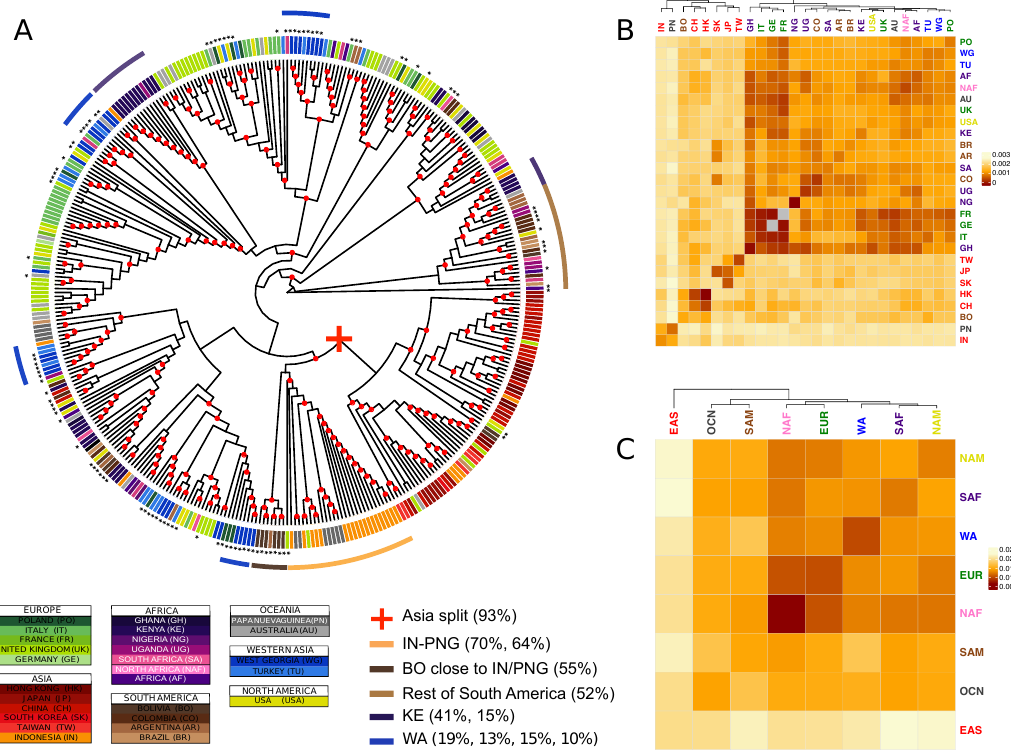
Figure 1. Major phylogenetic relationships. ( A ) Supertree generated by combining the phylogenies of all genes. The strain labels are coloured by country of origin. The countries of the same continent are coloured by di ff erent shades of the same colour. The new sequences produced in this study are identified by black asterisks. Nodes with bootstraps values higher than 0.5 are indicated with a red circle. ( B , C ) Heatmap representing the bootstrapped pairwise genetic distances between EBV populations weighted per all genes in the data set. Populations IDs correspond to the country of origin ( B ), or the continent of origin ( C ), and are coloured by continent. The colour of the heatmap cells is proportional to the genetic distance value (the closer the populations, the darker red the cell colour). Groups of isolates mentioned in the text are reported together with the proportion of the total number of isolates of the geographical